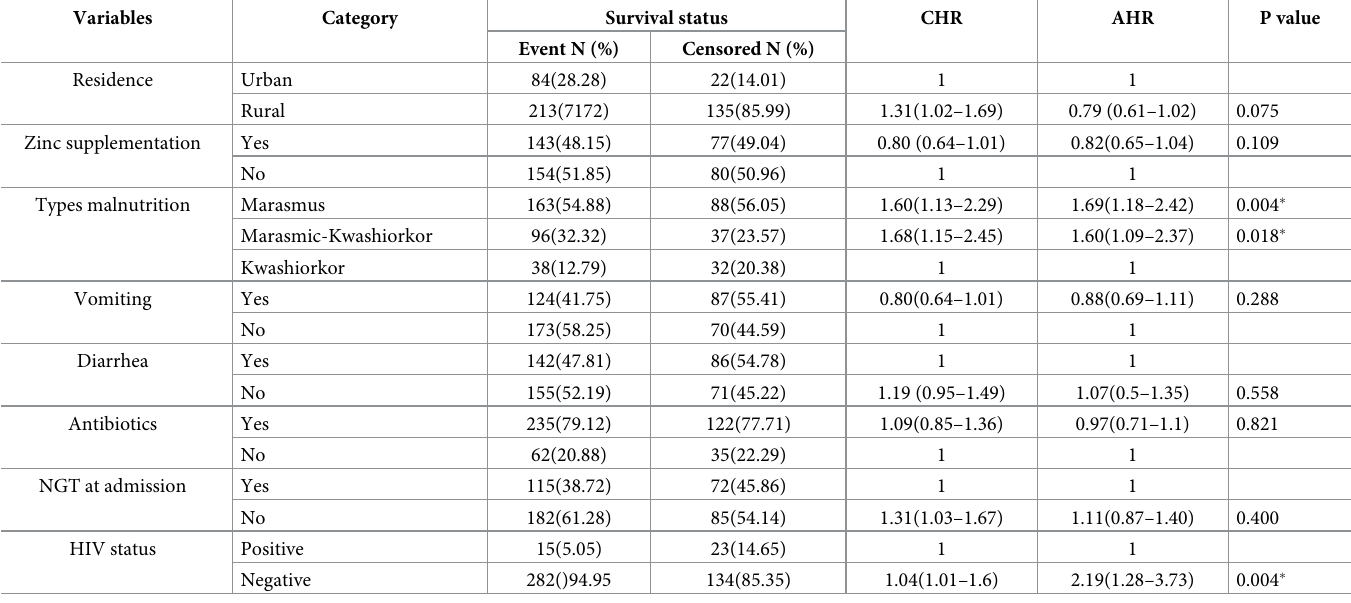
Table 3. Multivariable Cox-regression analysis predictors of time to recovery from SAM among 6–59 months old children at Asosa general hospital,